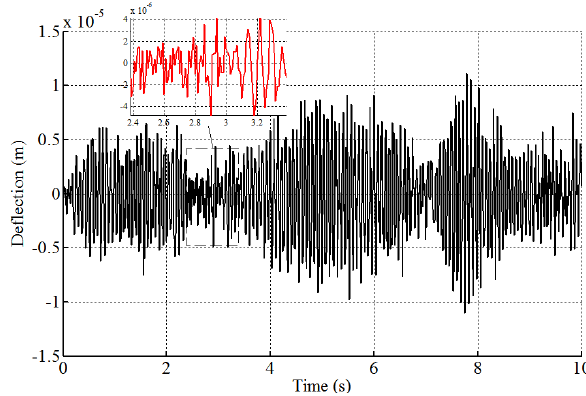
Figure 4: The tip deflection of the beam under random voltage exci- tation